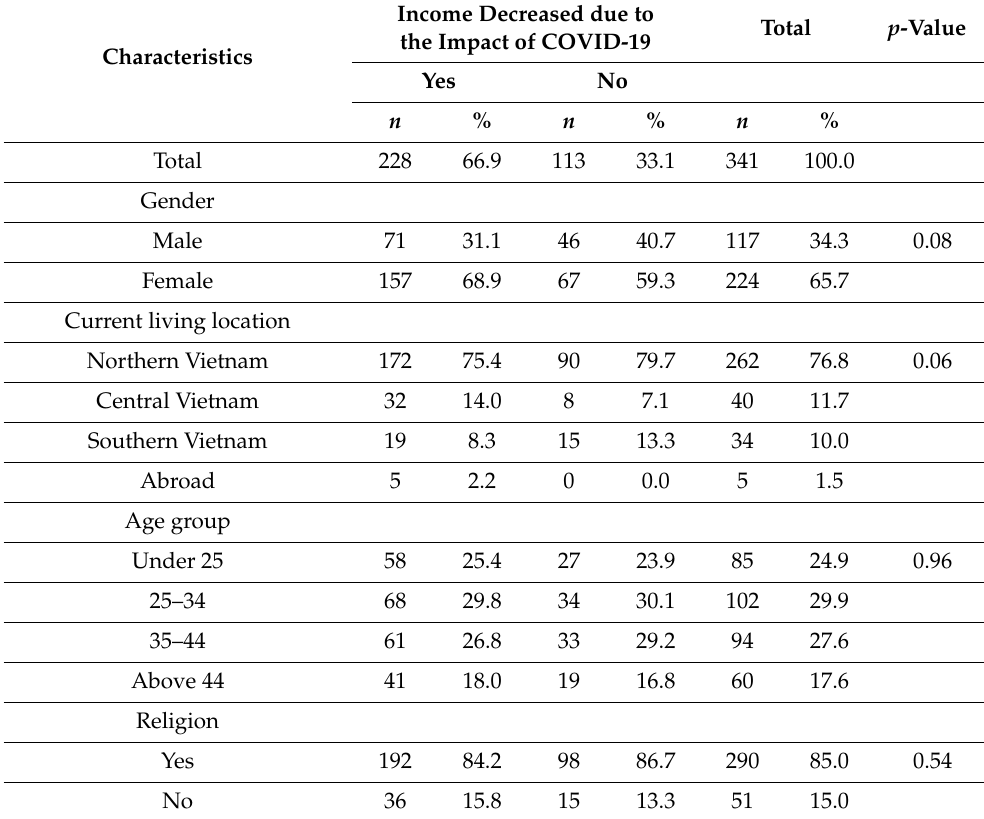
Table 1. Socioeconomic characteristics of